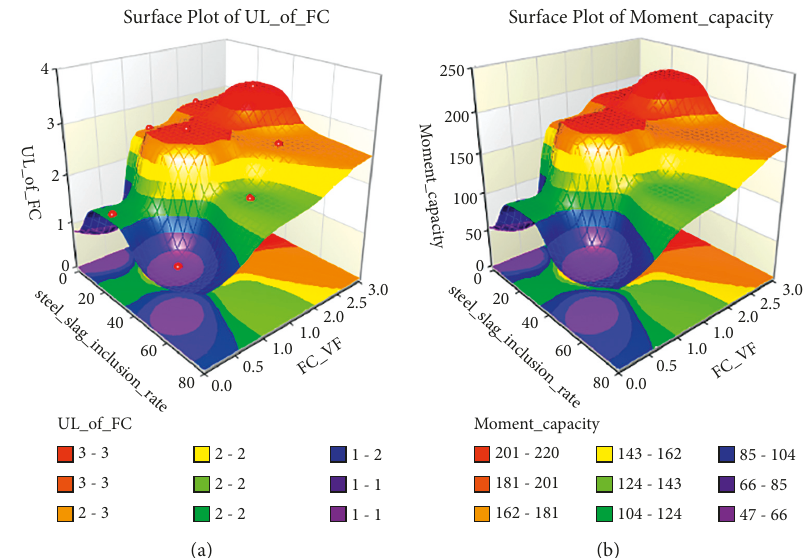
Figure 8: 3D Surface plot for: (a) ultimate load; (b) moment capacity.